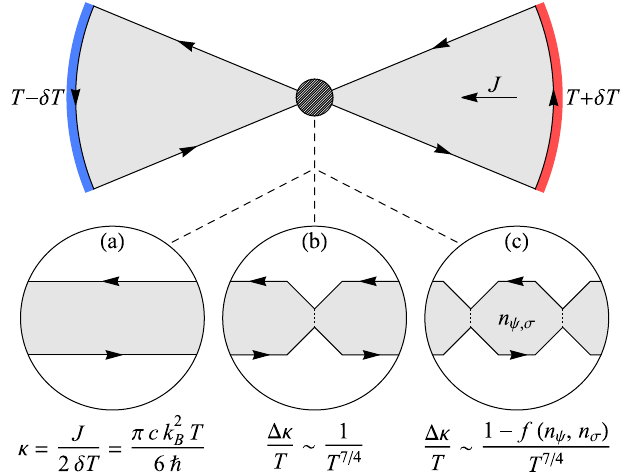
FIG. 1. Device geometry for extracting universal characteristics of the non-Abelian Kitaev spin liquid through conventional thermal transport in the presence of phonons. Two macroscopic lobes are bridged by a central mesoscopic region; heat current J flows from the right lobe (heated at the outer edge to temperature T þ δ T ) to the left lobe (cooled at the outer edge to T − δ T ). The two lobes facilitate edge-phonon thermalization, while the central region acts as a bottleneck for bulk phonon transport and, thus, emphasizes chiral edge transport. The central region contains (a) zero, (b) one, or (c) two pinch points at which the edge separation becomes comparable to the bulk correlation length — allowing edge anyons to tunnel between the two chiral edge modes. These tunneling processes can be detected by measuring the longitudinal thermal conductance κ of the device, directly obtained as the ratio of the heat current J and the temperature difference 2 δ T between the hot and the cold leads. If the phonon thermal conductance of the central region is sufficiently small, this measurement reveals the following universal spin liquid characteristics. (a) In the absence of any pinch points, the thermal conductance κ is directly proportional to the chiral central charge c ¼ 1 , whose half-integer value readily confirms the presence of 2 non-Abelian anyons. (b) For a single pinch point, the dominant low-temperature correction to the thermal conductance, Δ κ , follows a nontrivial power law with universal exponent 7 = 4 as a function of the temperature T , which reflects the tunneling of non-Abelian Ising anyons. (c) For two pinch points, the correc- tion Δ κ acquires an interference term f ð n ψ ; n σ Þ that is sensitive to the number of fermions ( n ψ ) and Ising anyons ( n σ ) between the two pinch points and thereby enables detection of individual bulk